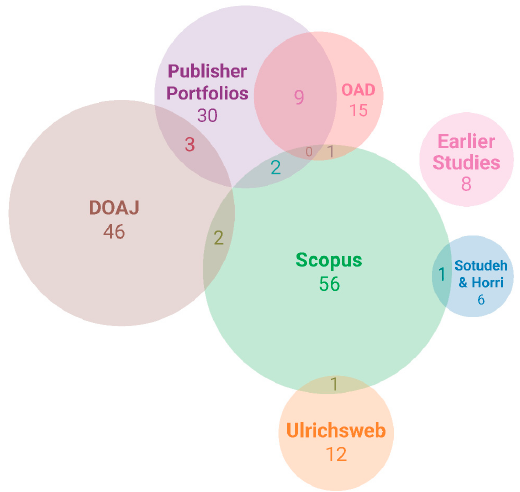
Figure 2. A Venn diagram visualizing data source overlap and contribution to the final dataset of verified reverse flips. Not displayed, the intersection of Open Access Directory (OAD) and Directory of Open Access Journals (DOAJ) and Publisher Portfolios (N = 1). Created with www.meta-chart.com [67].